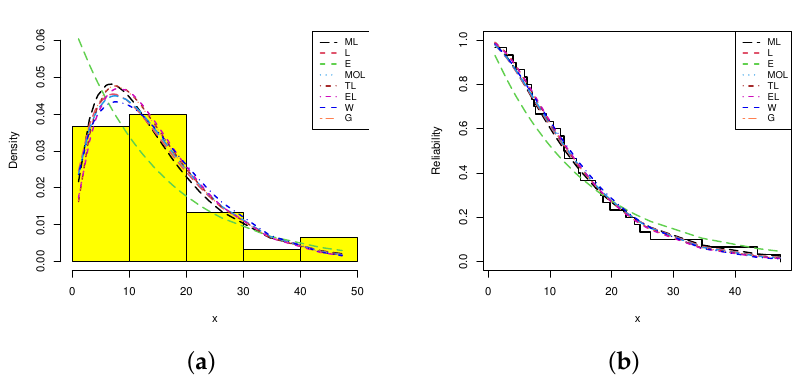
Figure 5. ( a ) Histograms/fitted PDFs; ( b ) empirical/fitted RF plots from mechanical equipment data.